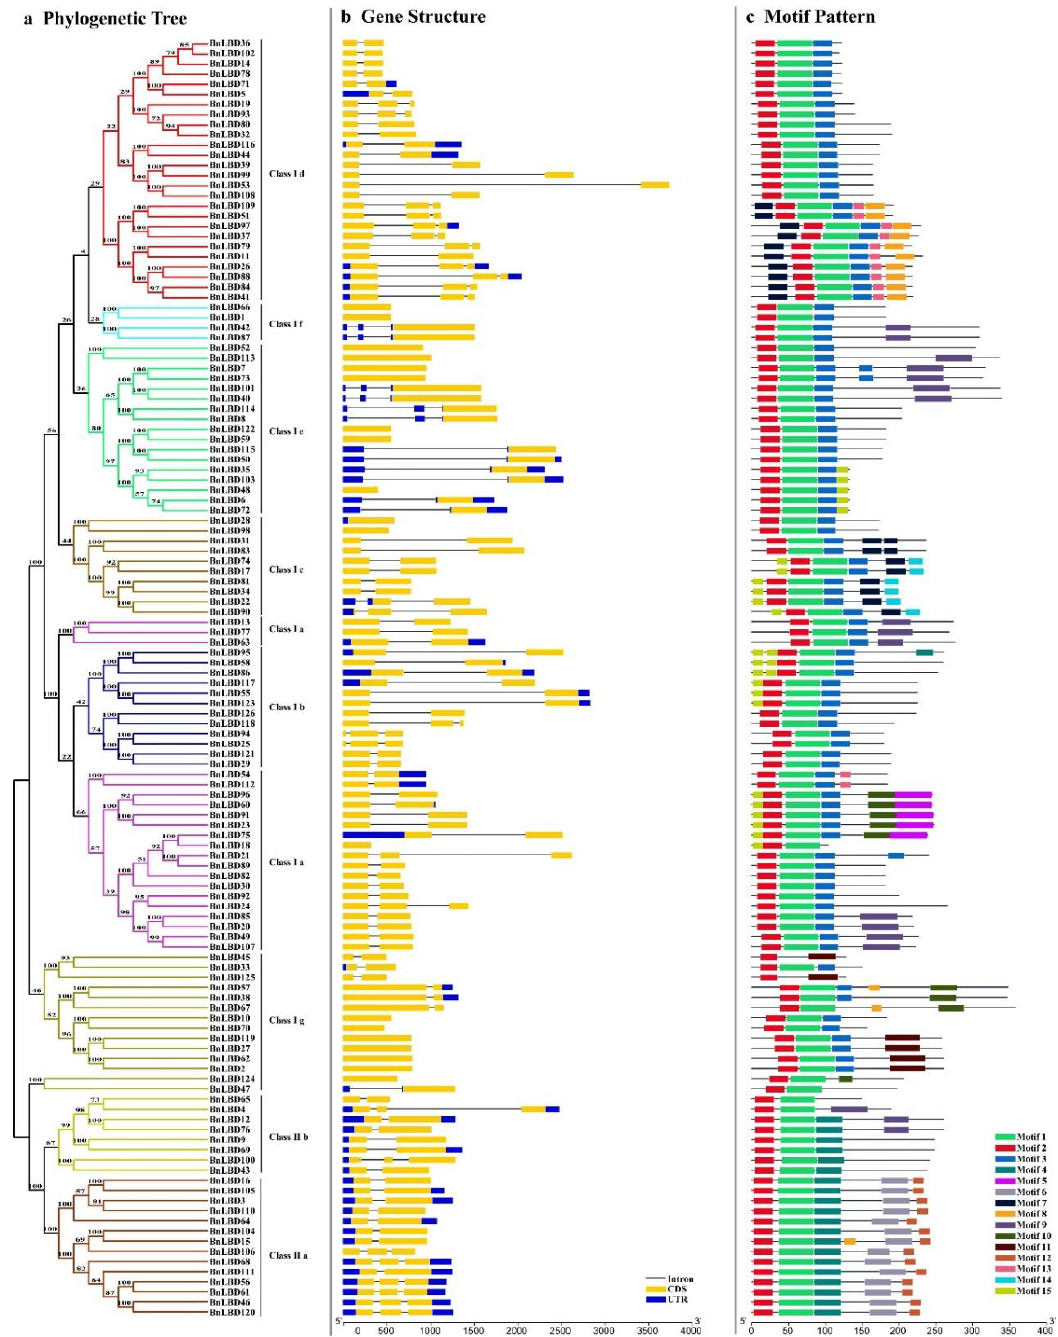
Figure 4. Phylogenetic relationships, gene structure, and motif composition analysis of the LBD family in B. napus . ( a ). The phylogenetic tree based on the full-length sequences of BnLBD proteins using MEGA 5 software. The different colors indicate different subgroups of BnLBDs. The number on the branches indicates the reliability percent of bootstraps value based on 1000 replications. ( b ). Exon / intron structure of BnLBDs. Blue boxes indicate 5 (cid:48) - and 3 (cid:48) -untranslated regions, yellow boxes indicate exons, and black lines indicate introns. The scale bar represents 0.5 kb. ( c ). The architecture of conserved protein motifs of LBD proteins. Motifs 1–15 are displayed in di ff erent colored boxes, and the motif structure is provided in Additional File 3. The scale bar represents 50 amino